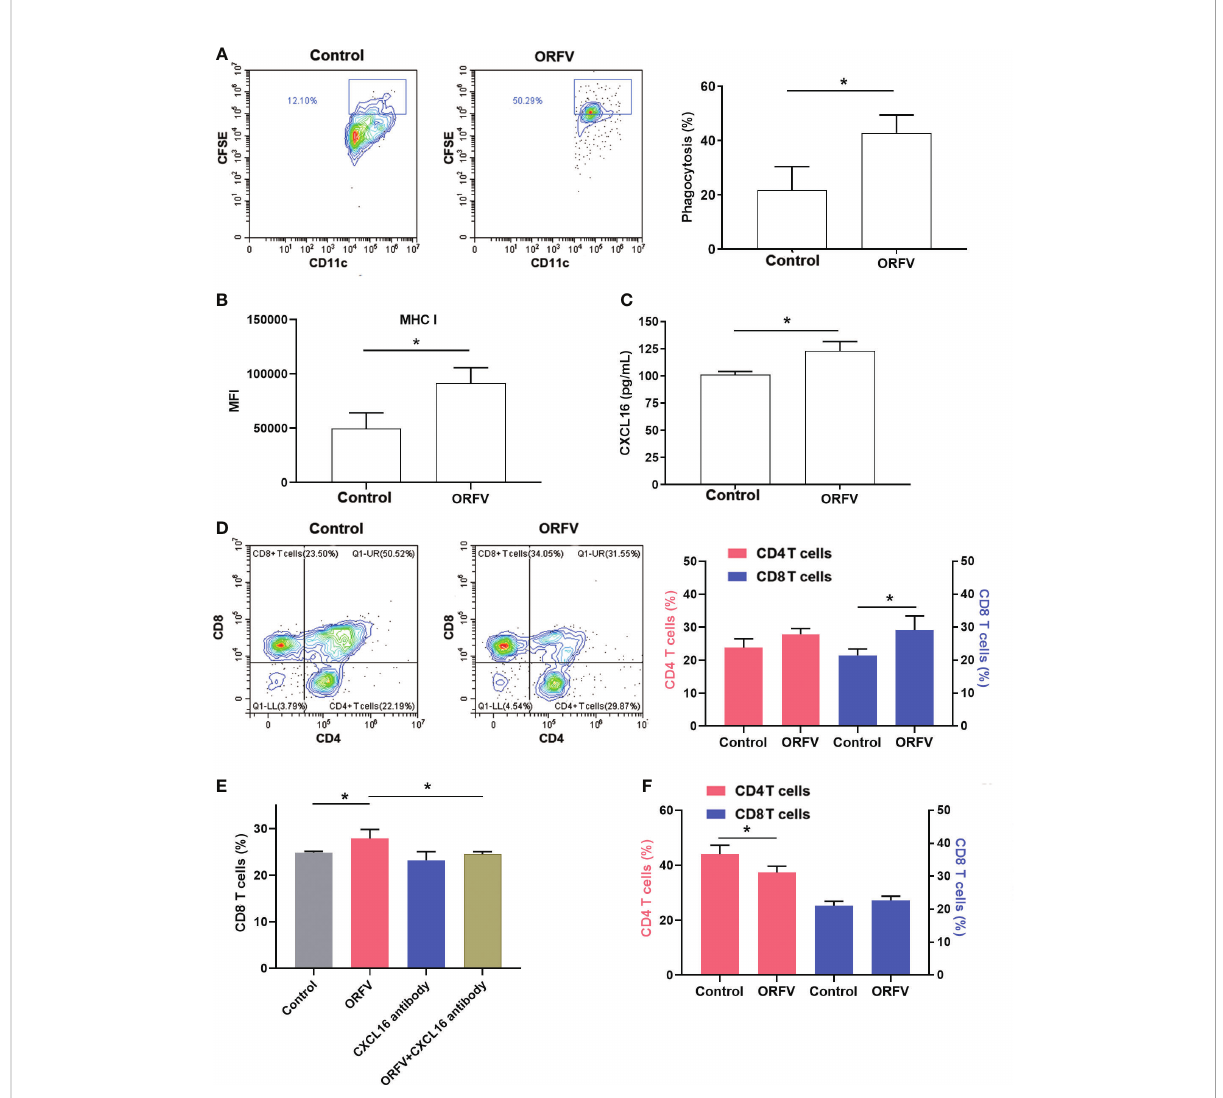
FIGURE 6 ORFV NA1/11 infection in lung cancer cells promotes DC activation and increases CD8+ T cell migration, dependent on the CXCL16/CXCR6 signaling. (A) Flow cytometry analysis of DC phagocytosis of CFSE-labeled tumor cells. LLC cells were labeled with CFSE and infected